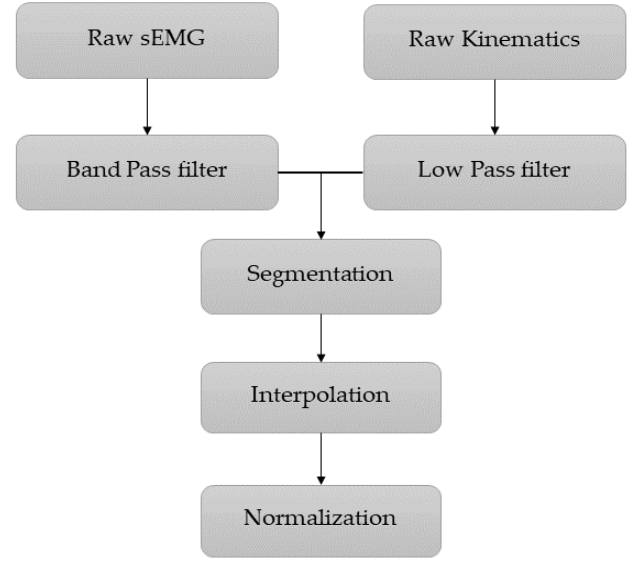
Figure 2. Block diagram of the pre-processing stage.